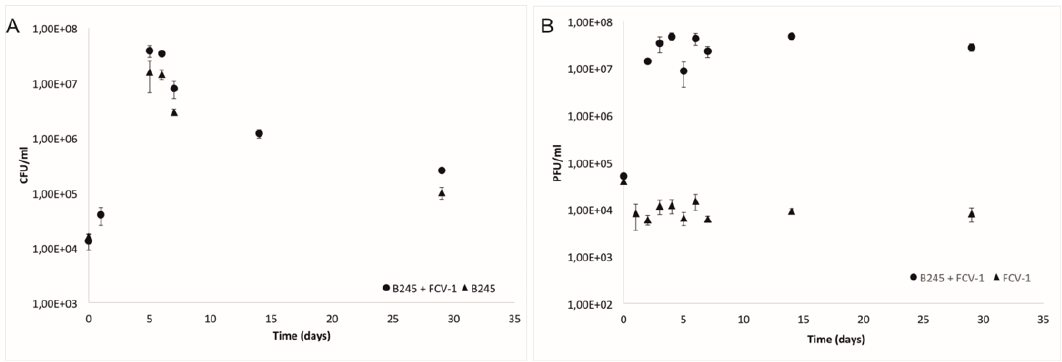
Figure 1. ( A ) Mean and standard deviation of colony forming units per mL (CFU/mL) of three replicates of Flavobacterium columnare strain B245 during the four-week experiment with phage FCV-1 and without phage. ( B ) Mean and standard deviation of plaque forming units per ml (PFU/mL) of phage FCV-1, with B245 and FCV-1 without bacteria.